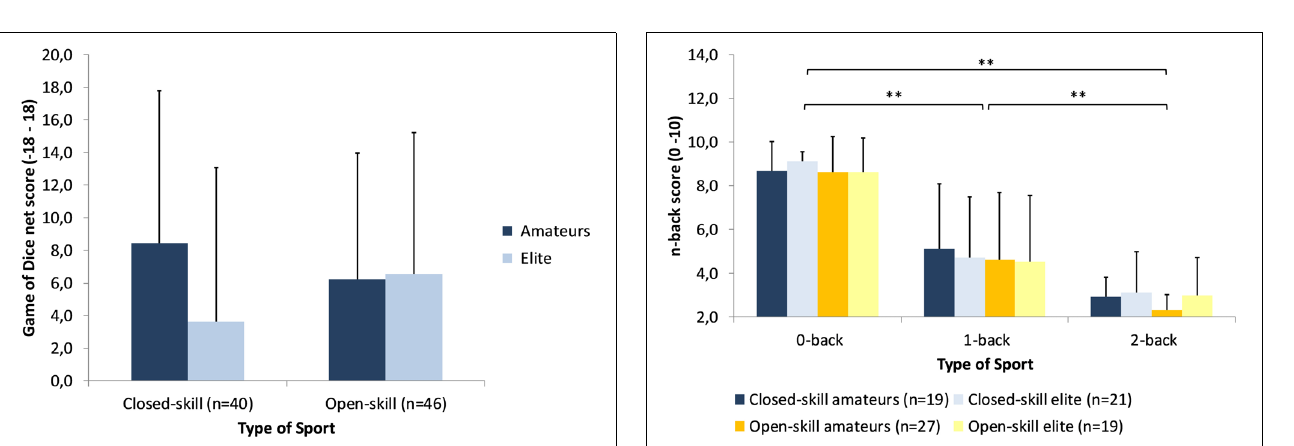
FIGURE 1 | The Game of Dice Task: net differences scores (advantageous choices–disadvantageous choices; mean, SD) across amateur and elite athletes from closed- and open-skills sports.